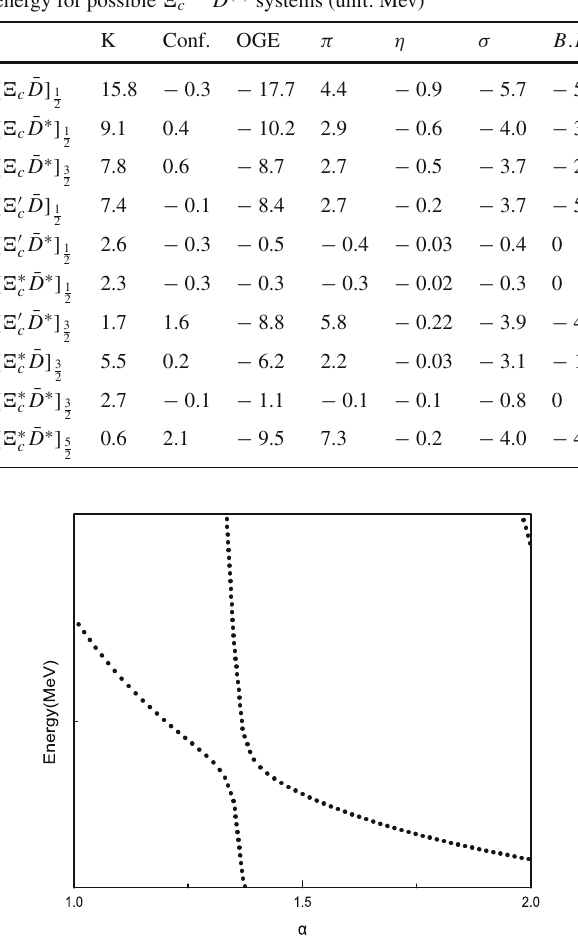
Fig. 1 The shape of the resonance in real-scaling method